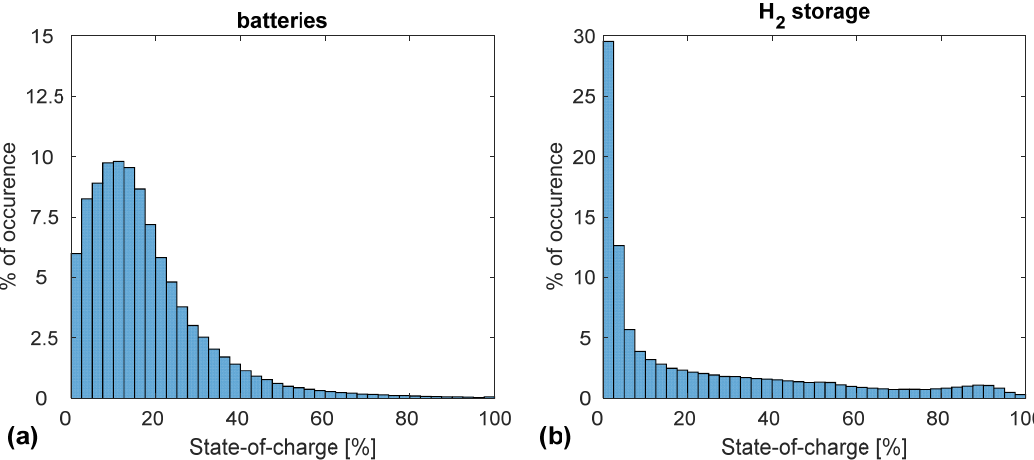
Figure 12. Frequency distribution of the state-of-charge for ( a ) batteries and ( b ) hydrogen tanks.